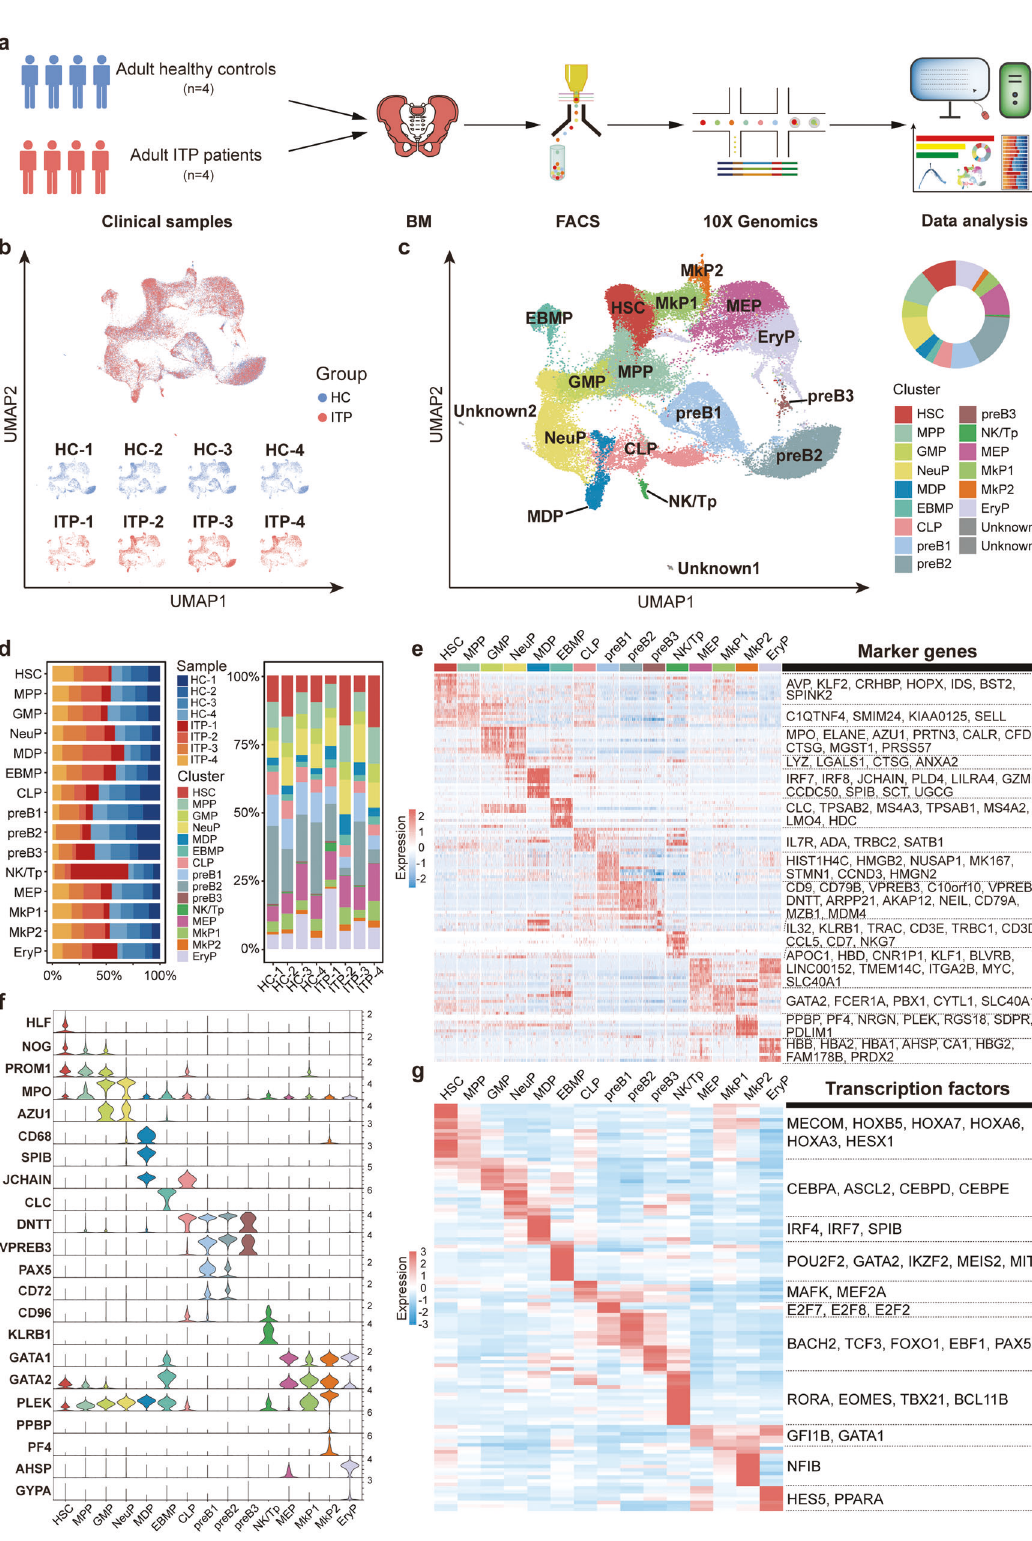
compared the transcriptomes of CD34 + HSPCs in ITP and healthy controls (HC) using single-cell RNA-seq (scRNA-seq) to reveal the overall transcriptome alterations in HSPCs in ITP. Our results provide new insights regarding the cellular and molecular basis of ITP